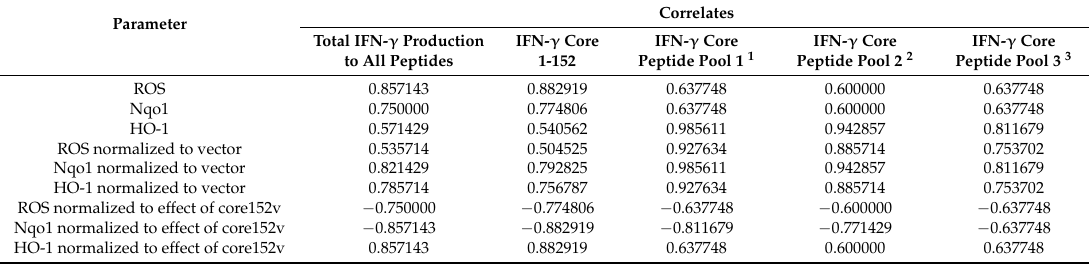
Table 1. Average IFN- γ production by splenocytes of HCV core DNA immunized mice after in vitro stimulation with HCV core-derived peptides correlate to the ability of respective core gene to induce ROS production and oxidative stress response. R values reflecting significant correlations are given in red ( p < 0.05; Spearman ranking